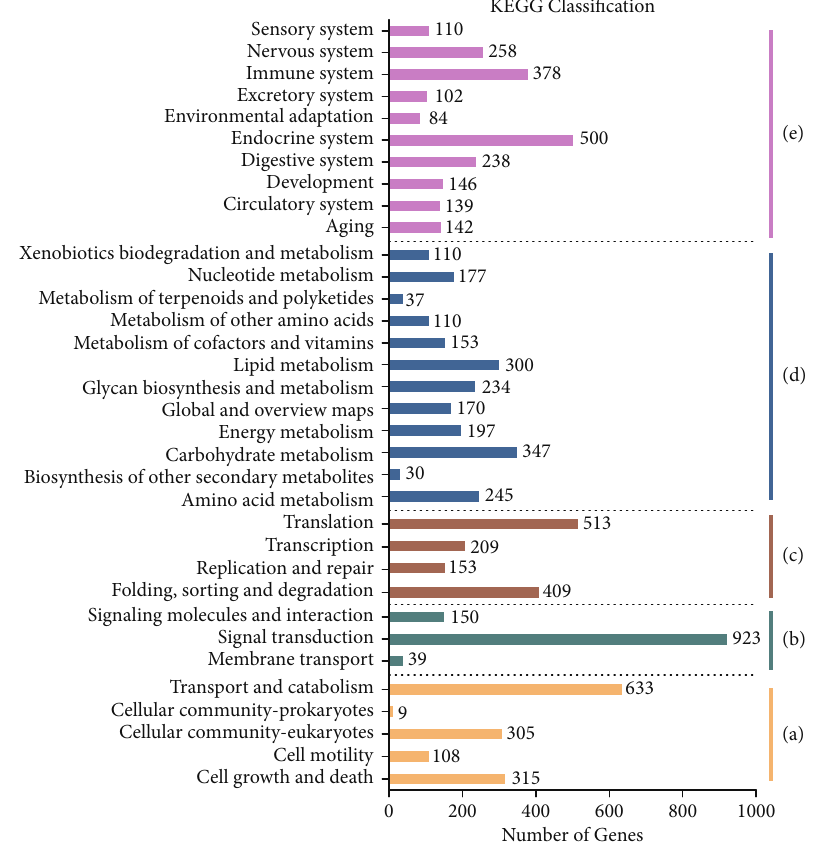
Figure 8: Highly expressed biological pathways represented in the KEGG database of C. quadricarinatus fed diets with di ff erent phospholipid sources for 10 weeks. a = cellular processes; b = environmental information processing; c = genetic information processing; d = metabolism; e = organismal